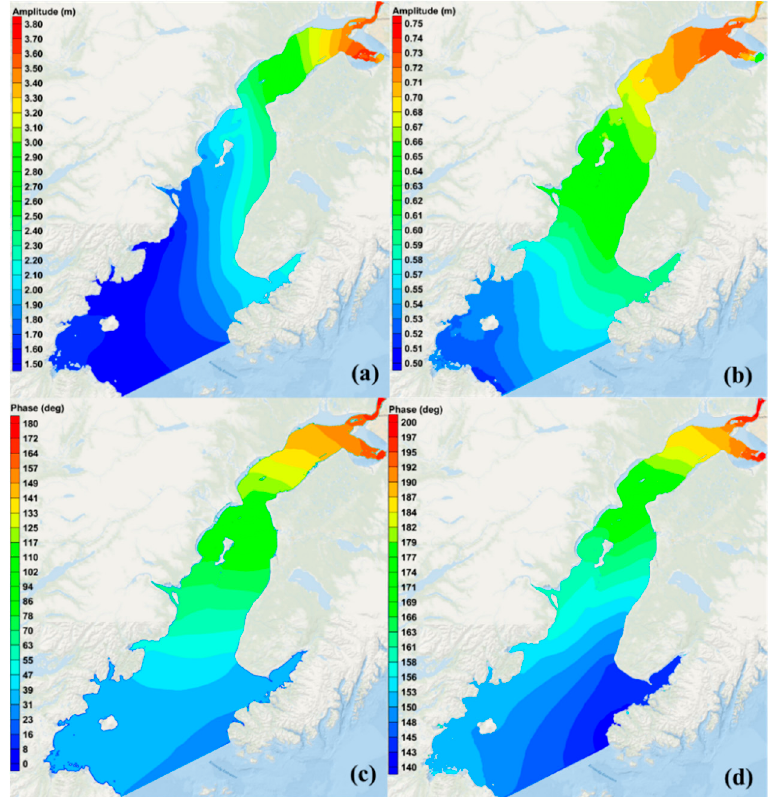
Figure 8. Two-dimensional distributions of tidal amplitude and phase inside Cook Inlet for the most dominant semi-diurnal (M2) and diurnal (K1) constituents ( a ) M2 amplitude; ( b ) K1 amplitude; ( c ) M2 phase; and ( d ) K1 phase. J. Mar. Sci. Eng. 2020 , 8 , x FOR PEER REVIEW